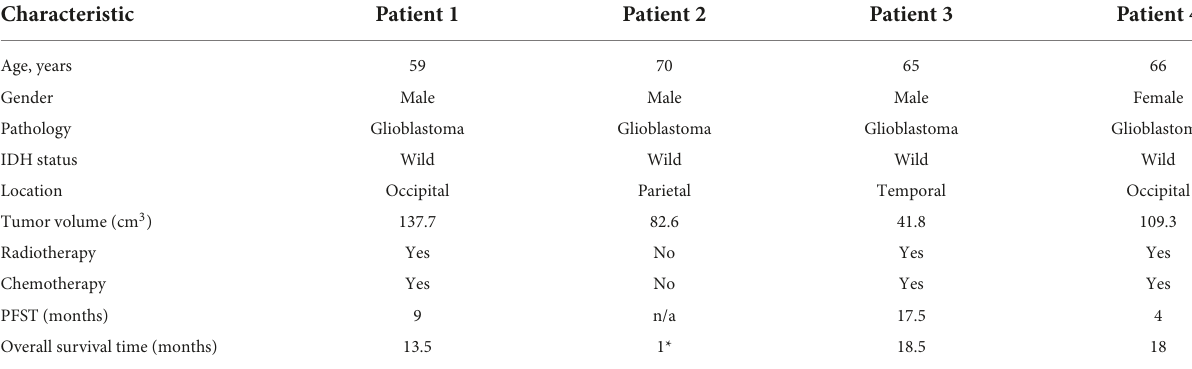
TABLE 1 Characteristics of patients who underwent surgical resection for glioblastoma.